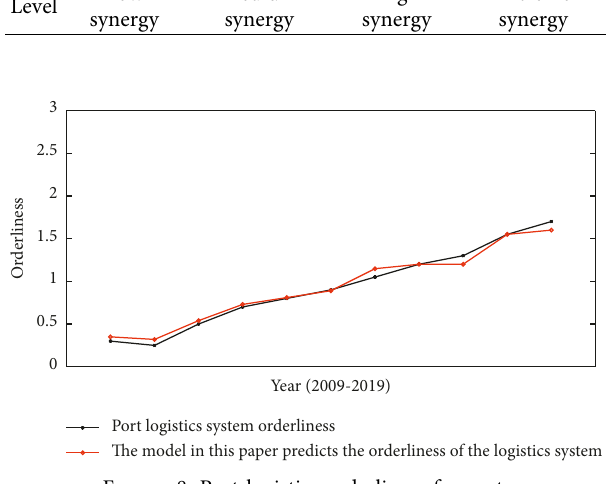
Figure 8: Port logistics orderliness forecast.